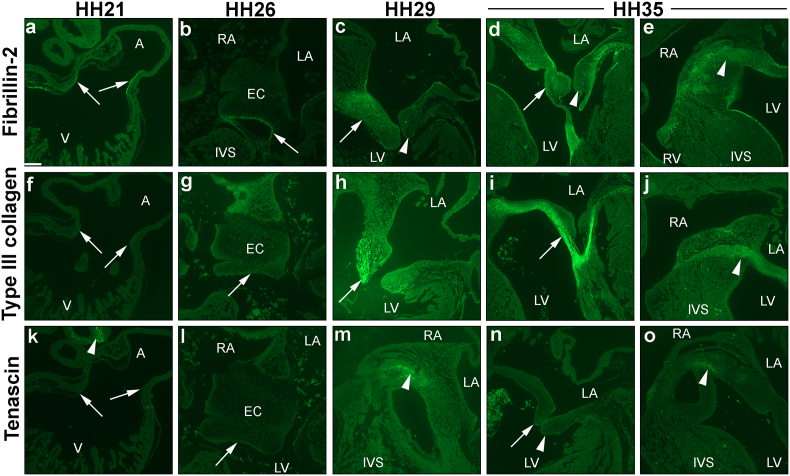
Cardiac spatial-temporal expression profile of fibrillin-2, type III collagen and tenascin. Chick hearts were isolated at HH21 (a, f, k), HH26 (b, g, l), HH29 (c, h, m) and HH35 (d, e, i, j, n, o), with staining for fibrillin-2 (a–e), type III collagen (f–j) and tenascin (k–o). Fibrillin-2 was expressed in the endocardium lining at the atrioventricular canal (AVC) at HH21 (a), whereas staining for type III collagen and tenascin was not observed at the AVC (arrows in f & k respectively) or in any parts of the developing heart besides the pharyngeal arches (arrowhead in k). At HH26, only fibrillin-2 was seen at the endocardial lining of the cushion mesenchyme (b); type III collagen and tenasin were negative (arrow in g & l). At HH29, fibrillin-2 and type III collagen were observed in the primordial mitral valve (MV) septal leaflet (arrow in c & h respectively; arrowhead in c denotes negative lateral leaflet). Tenascin expression was localized to the endocardial cushion (EC) at HH29 (arrowhead in m). At HH35, fibrillin-2 (d) and type III collagen (i) demonstrated positive staining in the primordial MV leaflet, with the most intense immunostaining seen in the chordae tendinae (arrow). Staining of tenascin remained negative in the primordial MV septal and lateral leaflets (arrow and arrowhead in n respectively). Widespread expression of fibrillin-2 (arrowhead in e) and type III collagen (arrowhead in j) was also observed in the central cushion. Tenascin expression was only seen in the cushion (o). A, atria; IVS, interventricular septum; LA, left atrium; LV, left ventricle; RA, right atrium; RV, right ventricle; V, ventricle; n = 2 per stage. Scale bar: 120 μm.